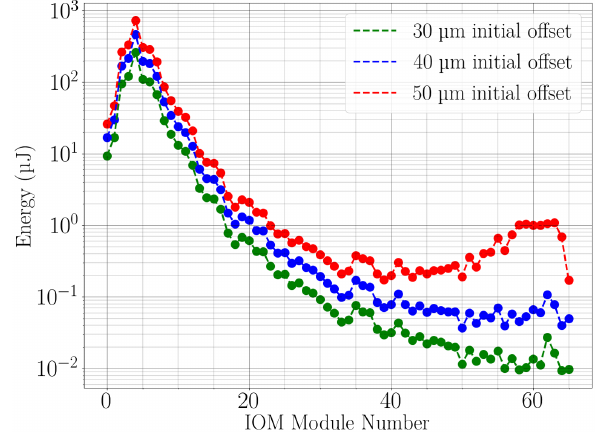
FIG. 18. IOM output energies for bunch trajectories with 30, 40, and 50 μ m initial offsets, showing instability developing for the 50 - μ m initial offset case after module number 40.